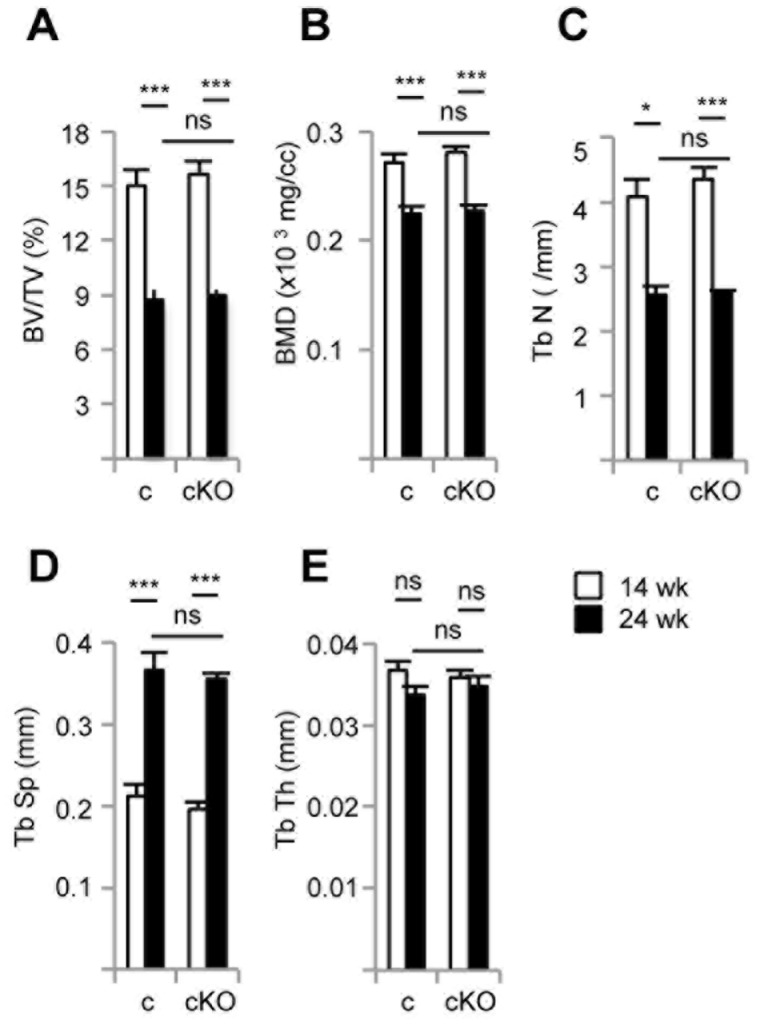
Conditional inactivation of ERRα in vivo does not impact bone ageing.Bone volume fraction (BV/TV; A), bone mineral density (BMD; B), trabecular number (Tb N; C), trabecular spacing (Tb Sp; D) and trabecular thickness (Tb Th; E) were determined by microCT-scan at 14 (white bars) and 24 wk (black bars) in the femur of female control (c) and conditional ERRα knock-out (cKO) mice (n = 6 to 11 per group). Error bars represent s.e.m. *: p<0.05; ***: p<0.005; ns: non significant.